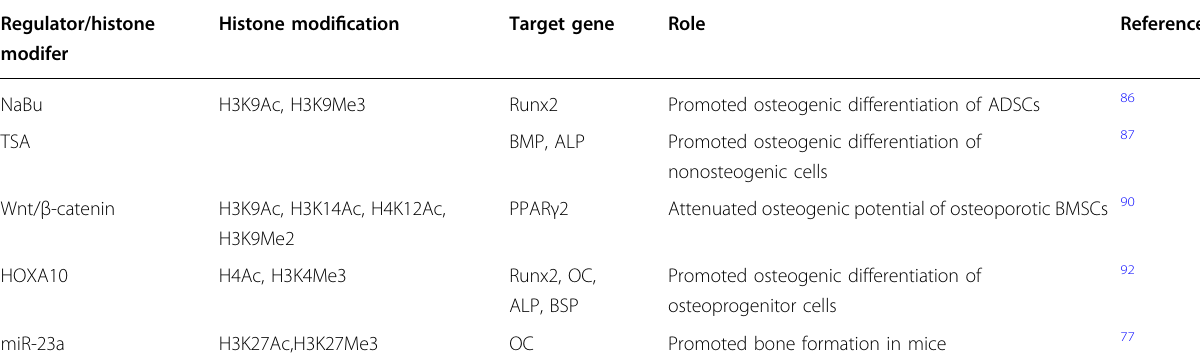
Table 3 Histone acetylation and methylation centric-regulation in osteogenic genes expression.